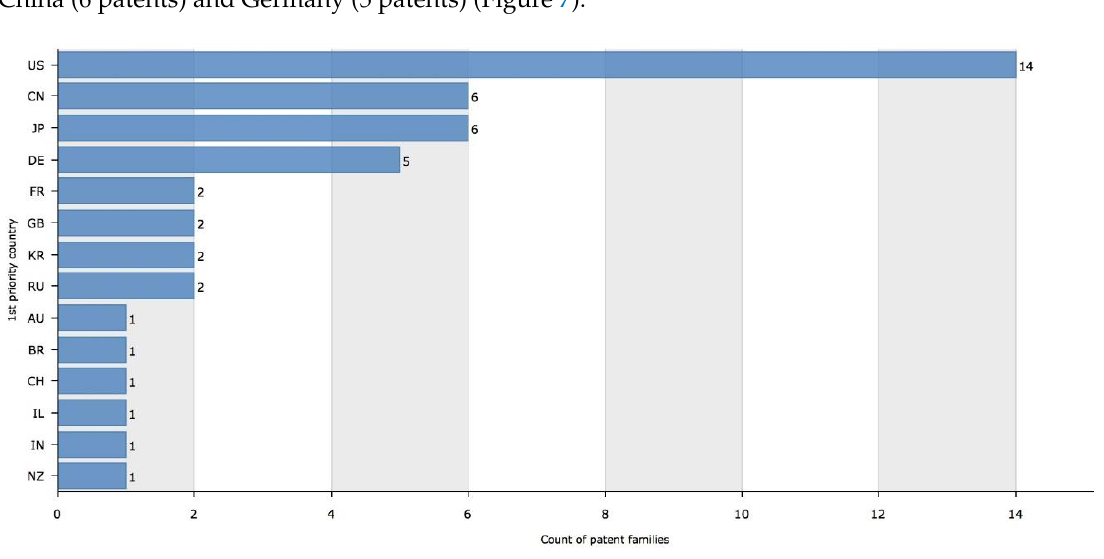
Figure 7. Patent families by priority country. Figure legend: US—United States; CN—China; JP—Japan; DE—Germany; FR—France; GB—United Kingdom; KR—Korea (South); RU—Russian Federation; AU—Australia; BR—Brazil; CH—Switzerland; IL—Israel; IN—India; NZ—New Zealand.